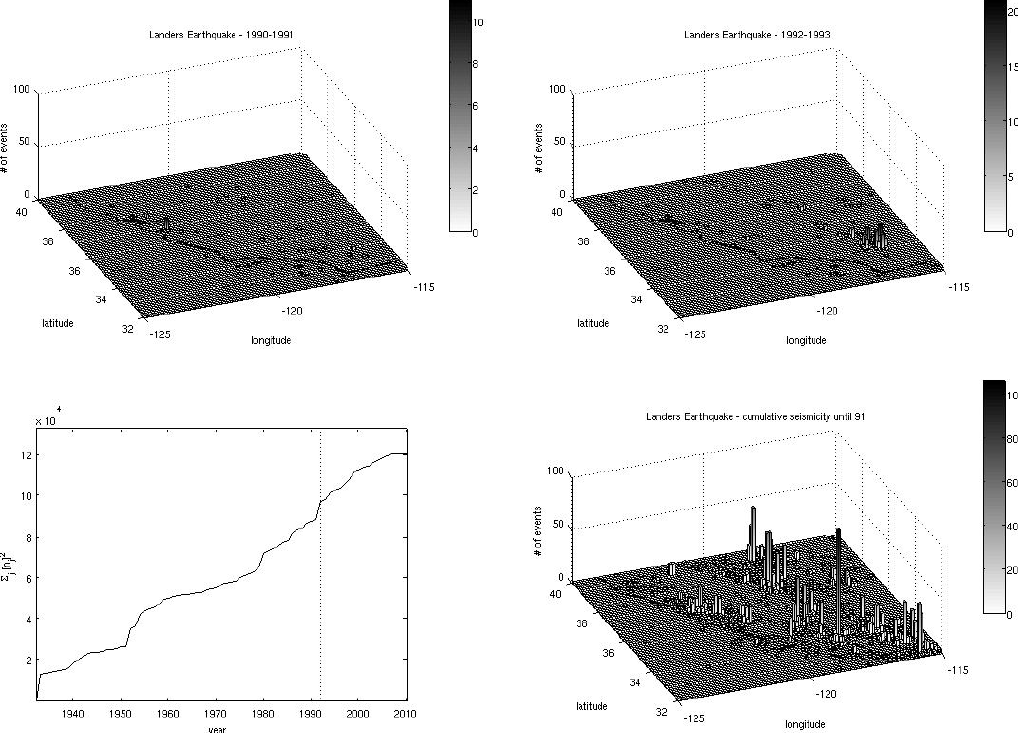
Fig. 5. Distribution of events before the 1992 Landers earthquake before the mainshock (top left), after the mainshock (top right) and up until the mainshock since 1932 (bottom right). The approximation in Eq. (4) with the time of occurrence of the 1992 Landers event as the dashed line are also plotted (bottom